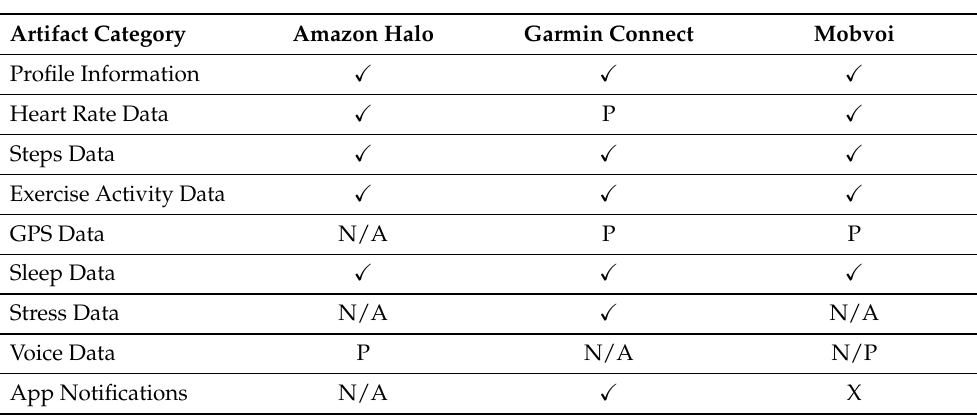
Table 6. Summary of Recovered